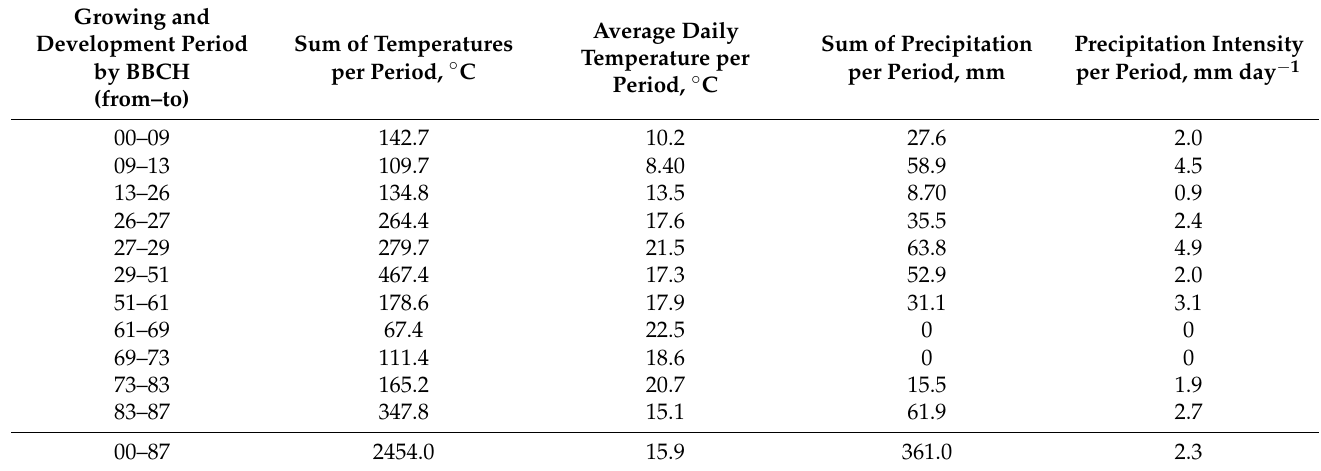
Table 4. Meteorological conditions (air temperature and precipitation) during the maize growing season in 2020.